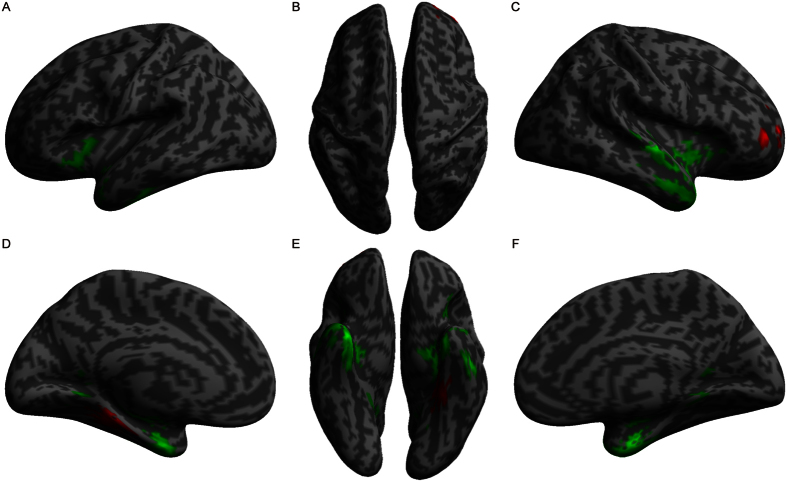
Correlations between hearing level and gray matter volume.The red color indicates voxels with positive relationships, and the green color indicates voxels with negative relationships. The hearing level was calculated as PTA value, and larger values indicate lower hearing ability.